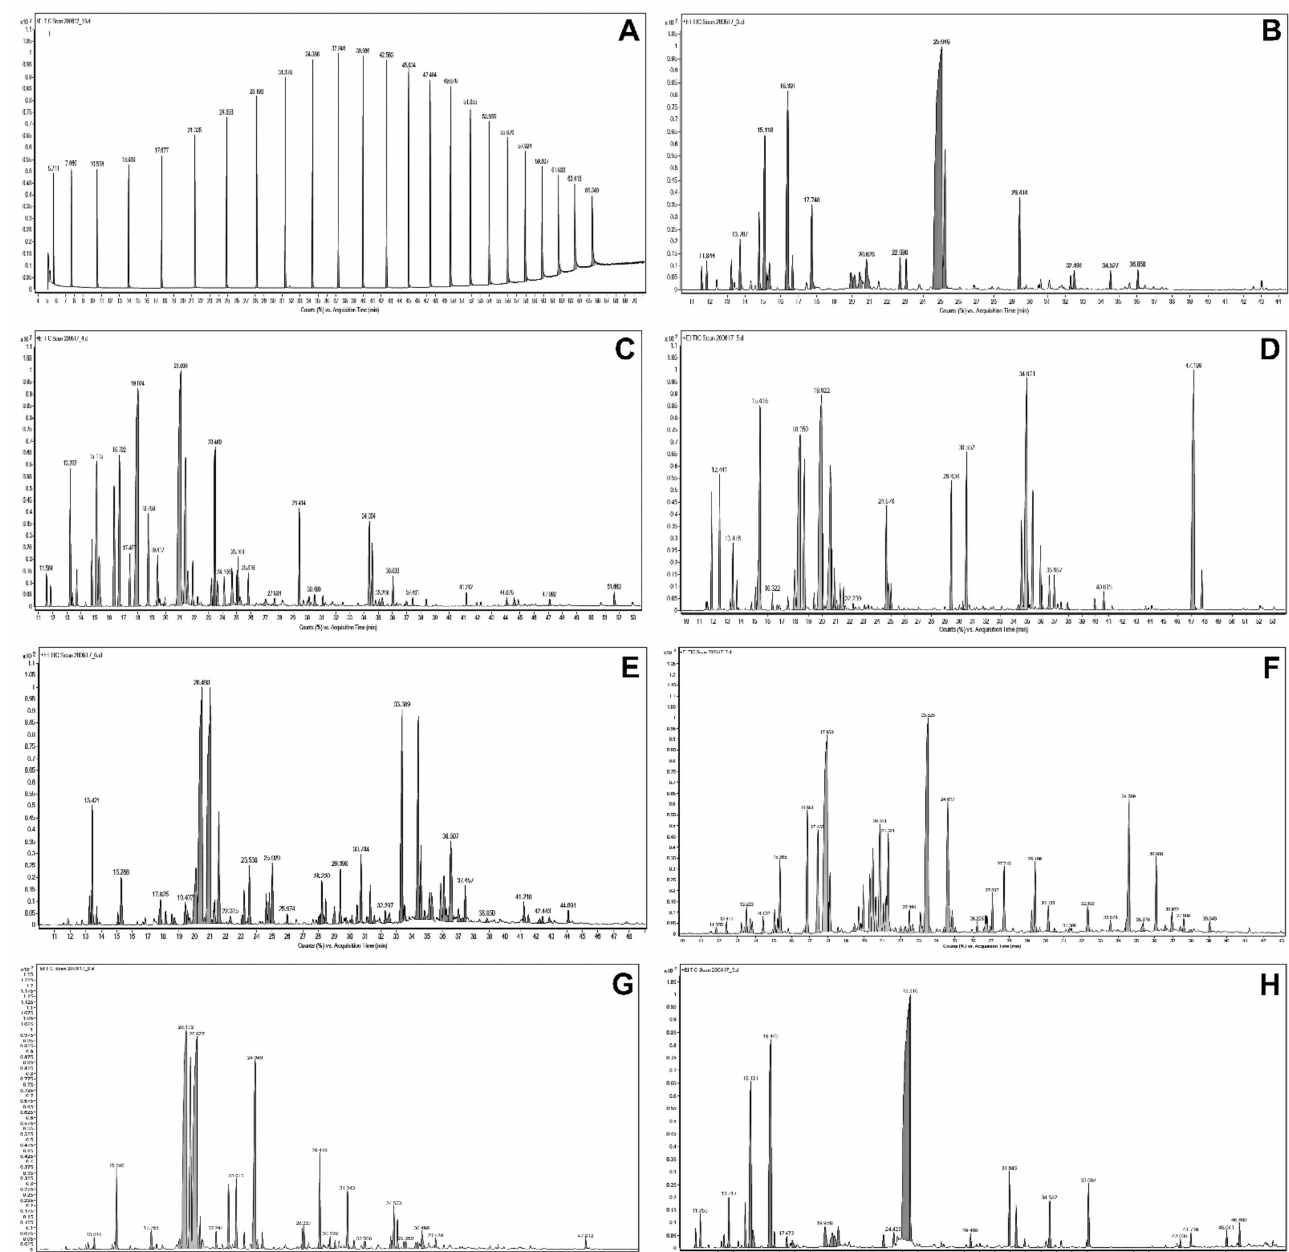
Figure 1. Chromatograms of serrated alkanes and analyzed essential oils; ( A )—C7-C30 alkanes, ( B )— T. vulgaris , ( C )— O. majorana , ( D )— S. officinalis , ( E )— H. officinalis , ( F )— L. augistifolia , ( G )— M. piperita , ( H )— S. hortensis